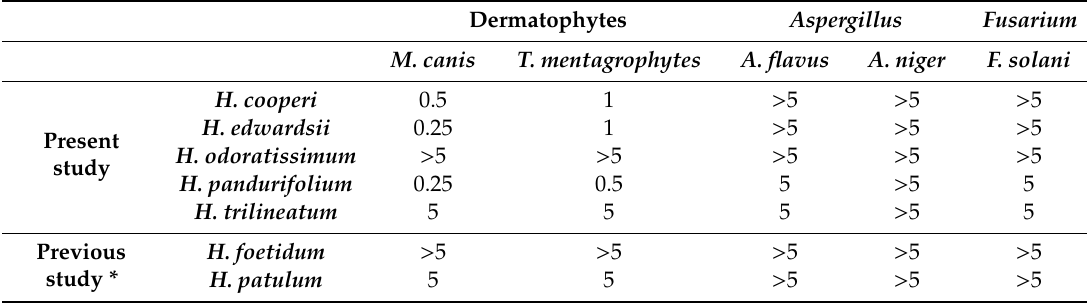
Table 5. Antifungal activity (in %) of the tested essential oils (EOs) of Helichrysum species. Dermatophytes Aspergillus Fusarium